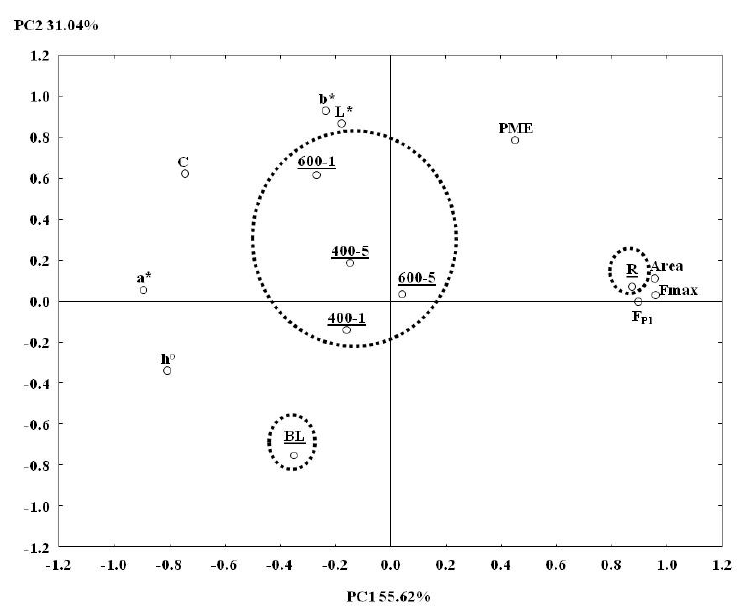
Figure 4. Principal Component Analysis (PCA) results obtained for the two principal components: Projection of the variables and of the cases on the factor plane (1 × 2). Abbreviations: R = raw/untreated; BL = blanched; 400-1 = HHP at 400 MPa for 1 min; 400-5 = HHP at 400 MPa for 5 min; 600-1 = HHP at 600 MPa for 1 min; 600-5 = HHP at 600 MPa for 5 min; F P1 = maximum force first peak; Fmax = absolute maximum force; Area = area under the force/time curve; PME = pectin methylesterase; L = lightness; a* = redness; b* = blueness; C = chroma; h° = hue angle; PC = Principal Component.